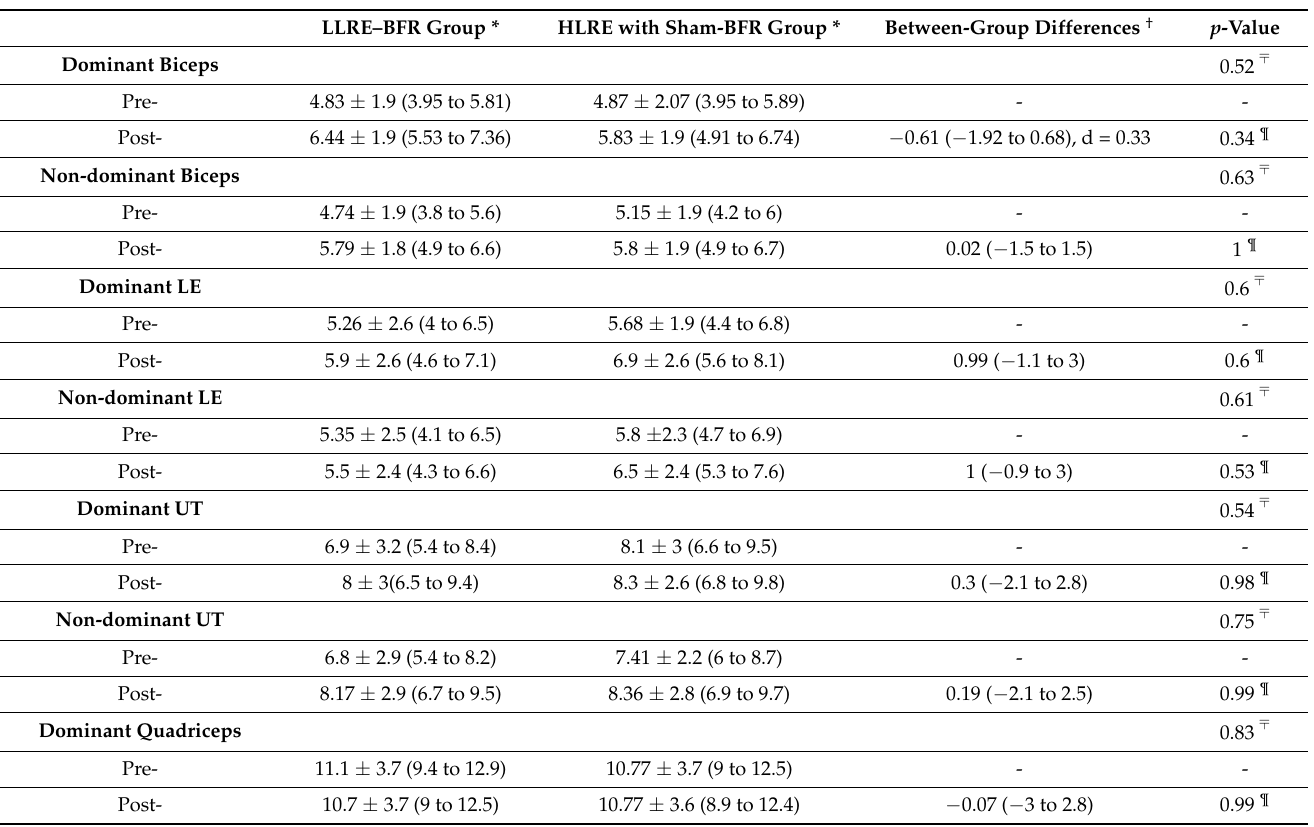
Table 2. Between-group differences of baseline-adjusted values of pressure pain thresholds and blood